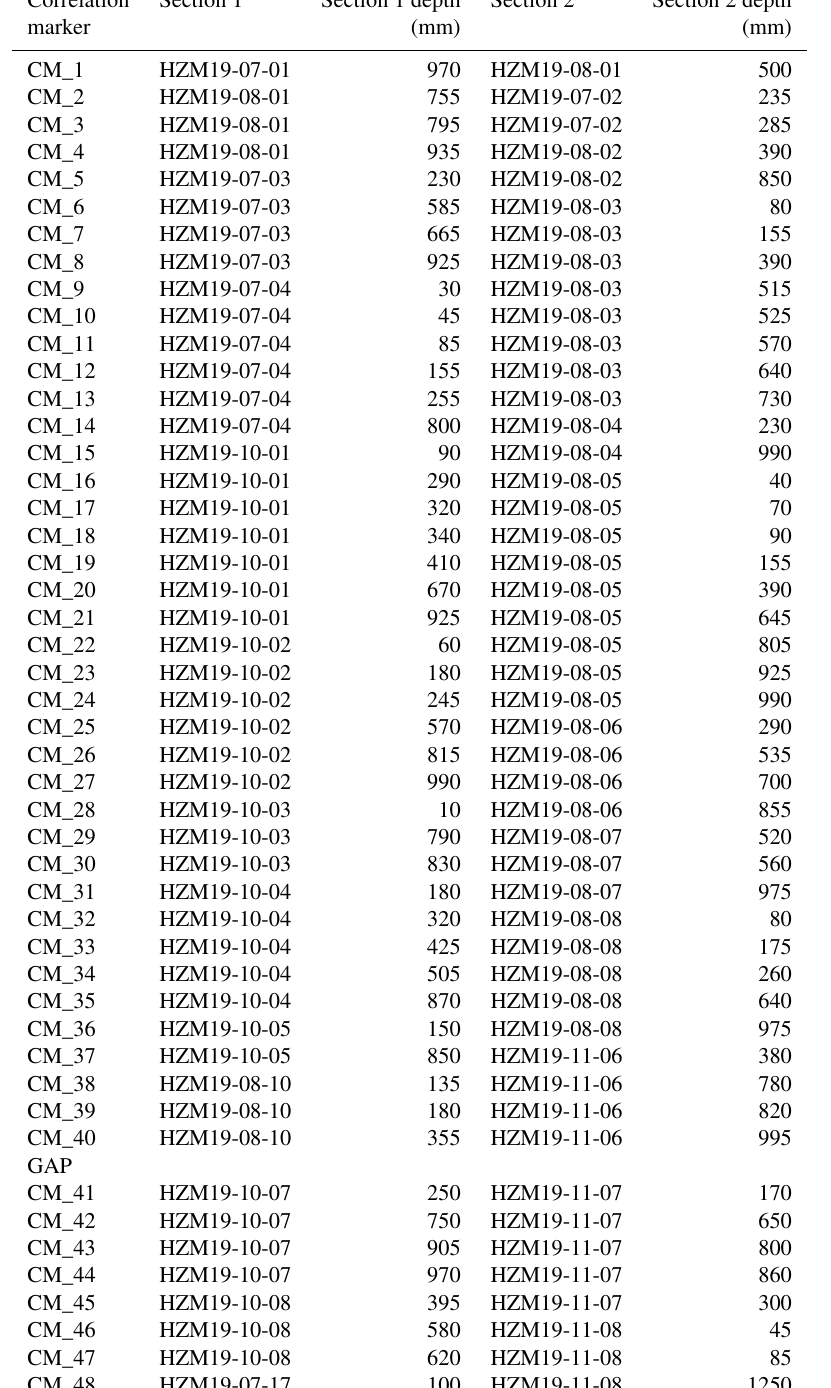
Table A3. List of markers used for correlation of core sections in HZM19.